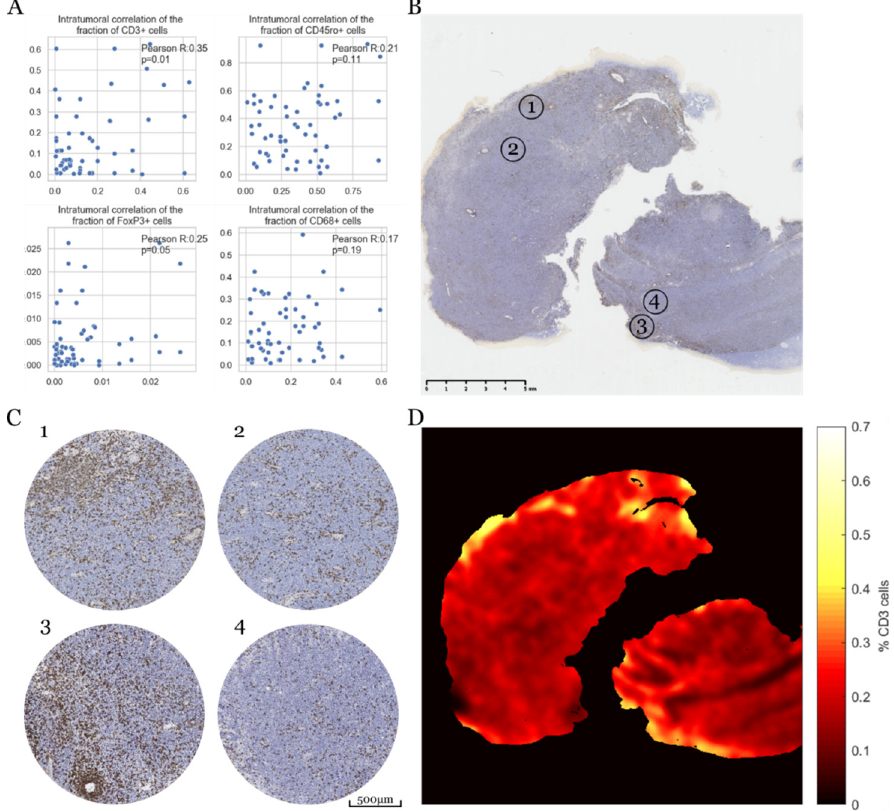
Figure 4. Spatially heterogeneous immune response in Primary CNS lymphoma (PCNSL). ( A ) Correlation of intratumoral TIL/TAM counts across multi-sector regions ( n = 26). ( B ) CD3 TIL staining of a large PCNSL specimen. ( C ) Virtual tissue cores randomly sampled from four sectors annotated in ( B ) demonstrate significant heterogeneity between immune hot and cold spots. ( D ) Heatmap of the CD3+ cell density with immune hot and cold spots across the whole slide scan.